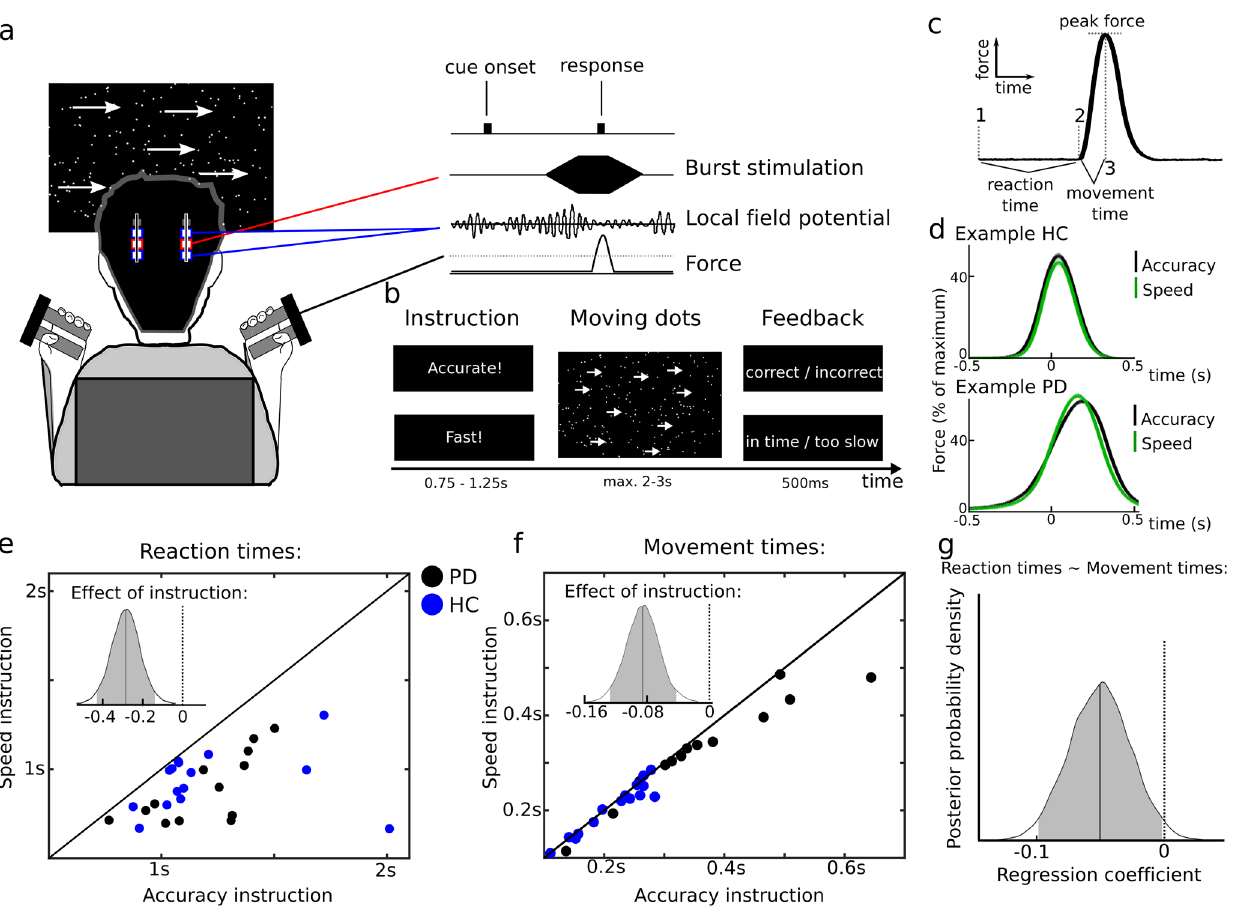
D Examples of trial-averaged force recordings are shown separately for speed (green)andaccuracy(black)trialsforonehealthycontrol(HC)participantandone PD patient. E Singleparticipant meanreaction times for speed ( y axis) vs. accuracy trials( x axis).Theposteriordensityoftheeffectofinstructionisshownintheinset. PD patients ( n =13) are shown as black circles, HC participants ( n =15) as blue circles. F Same as E but for movement times. G Posterior density of the regression coef fi cient of movement times on reaction times. Source data are provided as a Source Data fi